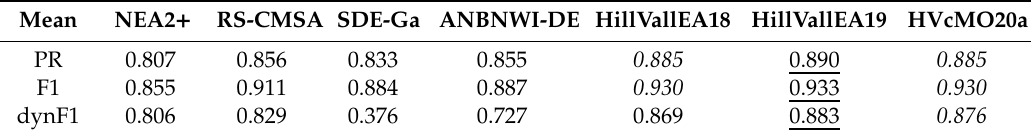
Table 6. Friedman test. Since p -value < 0.05 ( α ), each null-hypothesis is rejected. Table 5. Scores averaged at all accuracy levels over the entire validation suite.